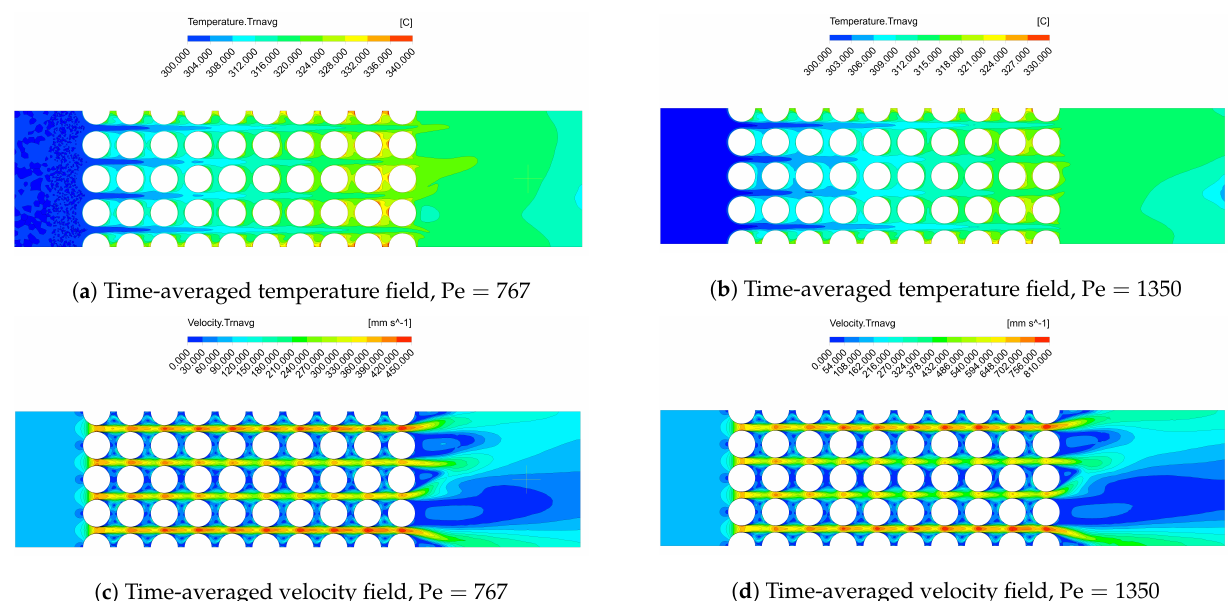
Figure 6. Numerical results for the a = 1.25 in-line